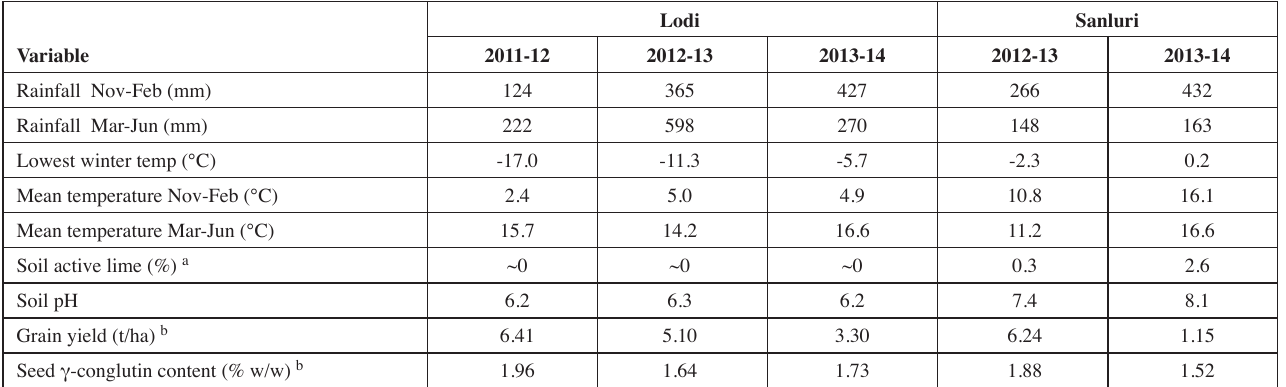
Tab. 1: Climate and soil characteristics, and mean white lupin grain yield and seed γ-conglutin content, for two test locations (Lodi, Northern Italy; Sanluri, Sardinia) in different growing